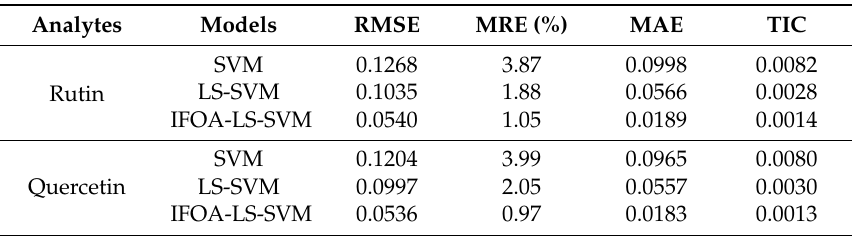
Table 2. Prediction performance of different models on the testing dataset of analytes. Analytes